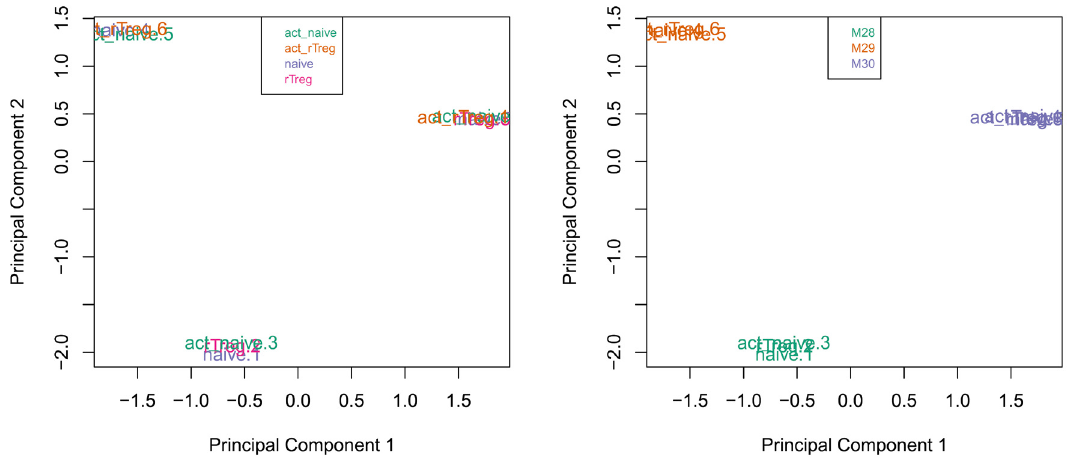
Figure 4. Multi-dimensional scaling plots are a good way to visualise the relationships between the samples in an